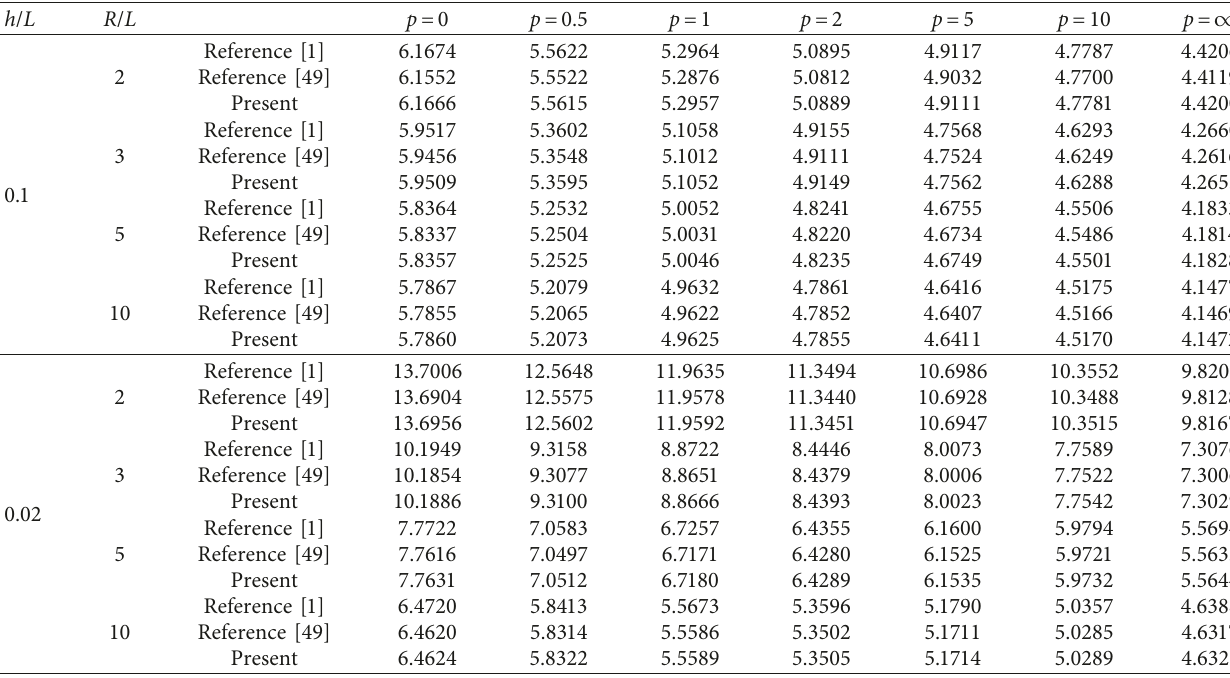
Table 2: Comparison of fundamental frequency parameters for functionally graded open cylindrical shells with SSSS boundary condition L ). ( L 1m, θ 1 R (cid:31) (cid:31) h / L